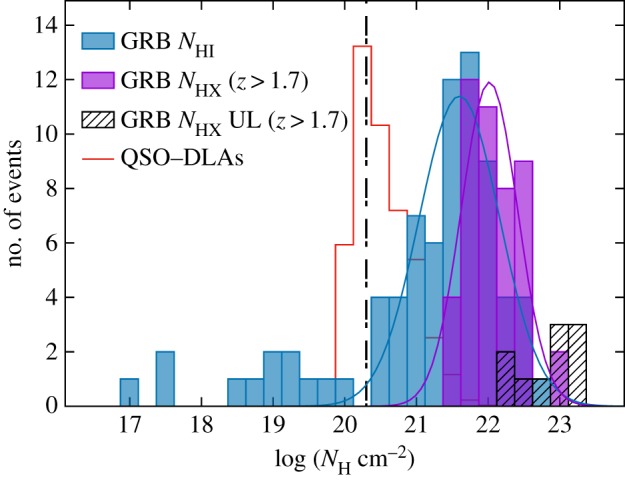
Distribution of host galaxy H i column densities measured from Lyman-α absorption along the line of sight to 77 long GRBs (blue), and equivalent H i column density (purple) and upper limits (black hashed) measured from the afterglow X-ray spectra when assuming solar metallicity for 56 long GRBs taken from [239]. The Lyman-α-derived column densities are taken from [219,222,240–242]. The distribution of NHI and NHX column densities above 1020.3 cm−3 (black dash-dot line) are well described by a Gaussian with peak log⁡NHI cm−3=21.6 (blue line) and log⁡NHX cm−3=22.0 (purple line), and respective standard deviations σNHI∼0.6 and σNHX∼0.4. As a comparison, the NHI column density distribution of 1426 QSO–DLAs and QSO-subDLAs from [243] is also shown (red), normalized to have the same number of events at the peak of the distribution as in the GRB NHI distribution.